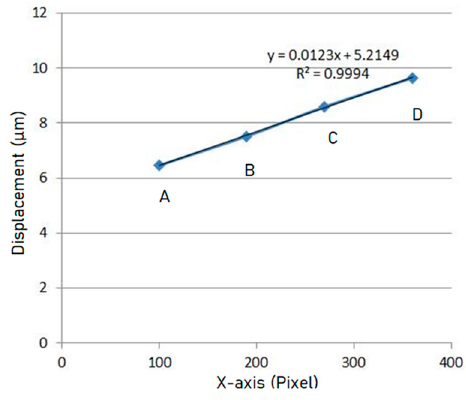
Figure 13. The linear relationship of the displacement of 4 pixels.